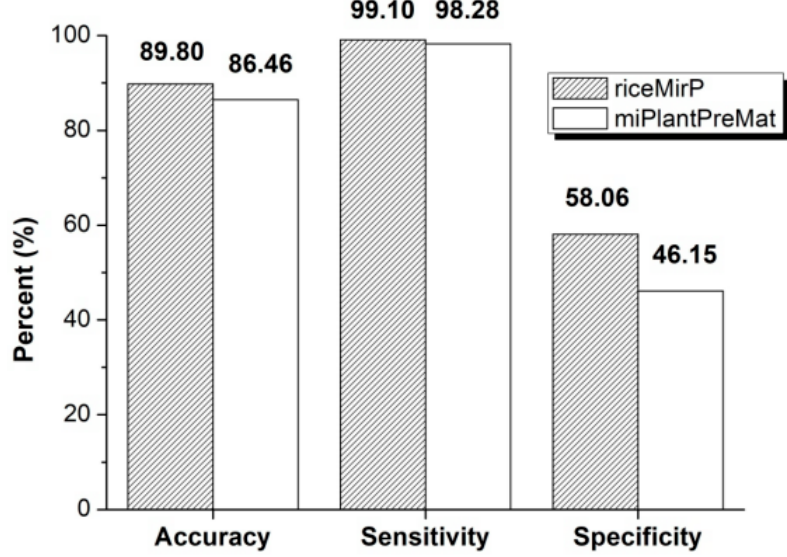
Figure 6. Accuracy (Ac), sensitivity (Se), and specificity (Sp) of riceMirP and miPlantPreMat based on the datasets from miPlantPreMat and PlantMiRNAPred.